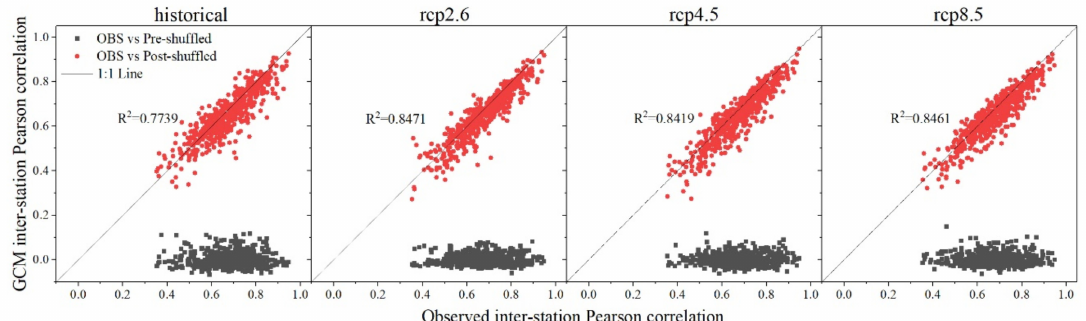
Figure 9. The inter-station Pearson spatial correlation for observation (OBS), CLIGEN-generated single-site precipitation sequences (pre-shu ffl ed, without using shu ffl e procedure) and shu ffl ed precipitation sequences (post-shu ffl ed, using shu ffl e procedure) with adjusted the input